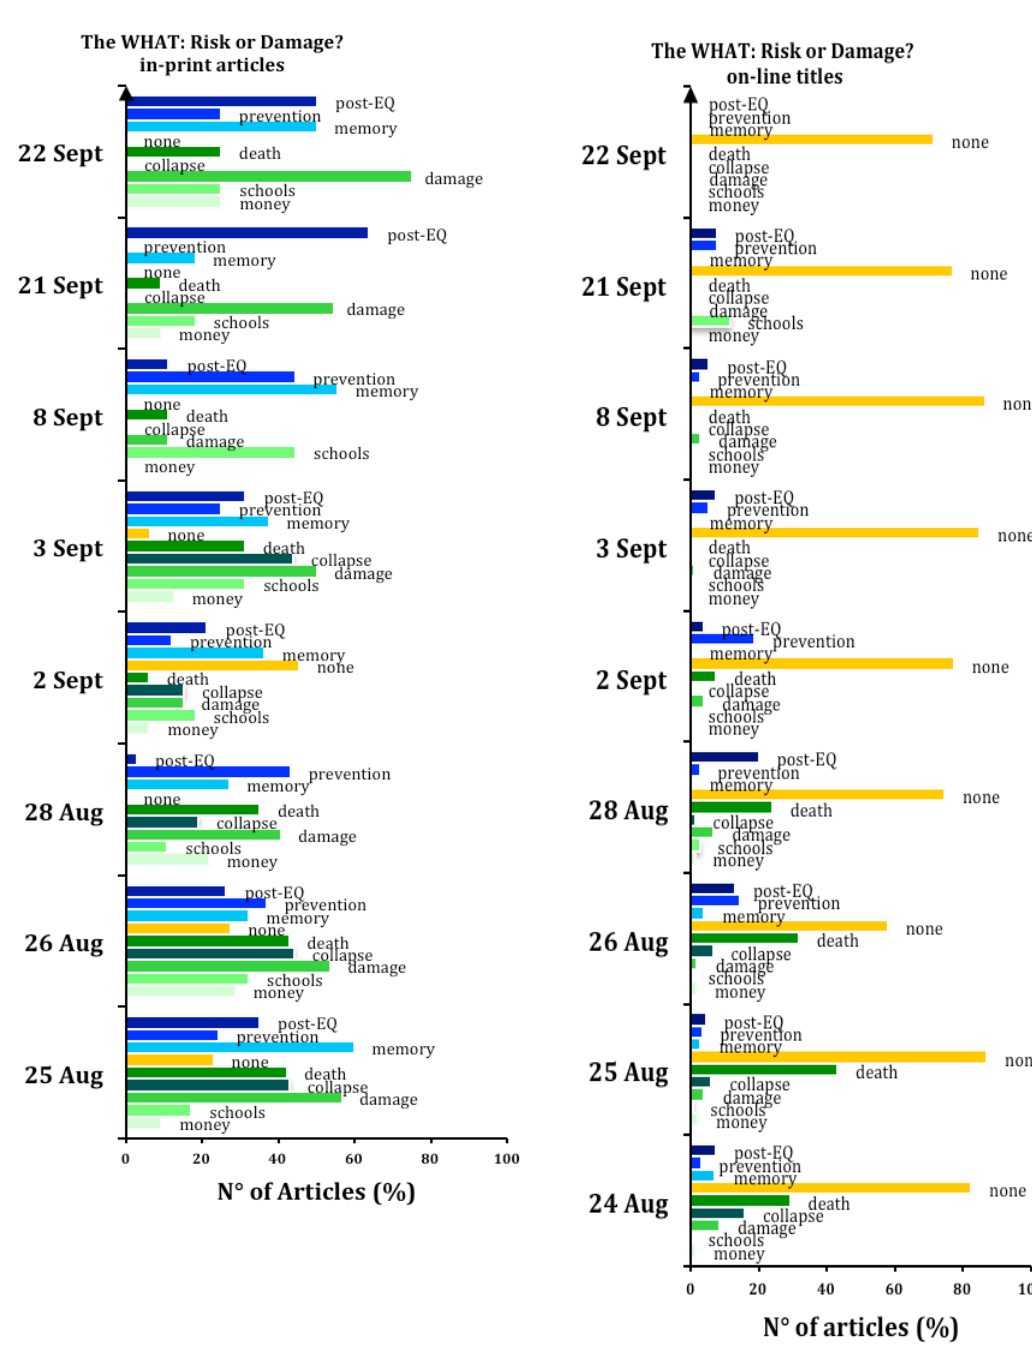
Figure 4. Risk reduction and damage indicators versus time. The memory of past earthquakes is always present